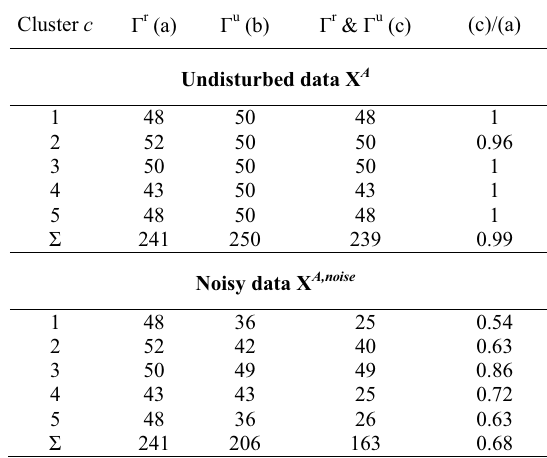
Table 6. Number of patterns assigned to the same cluster in (cid:299) r and (cid:299) u in case of undisturbed and noisy data.